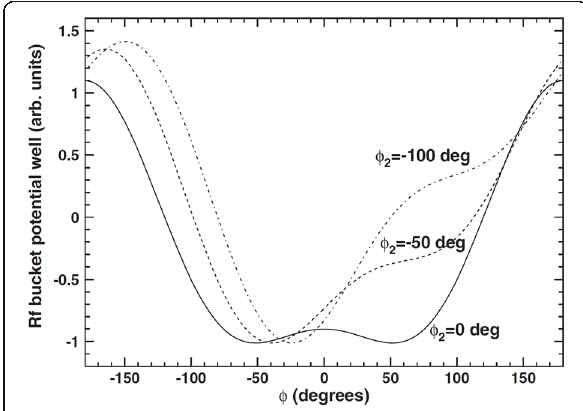
Fig. 16 Temporal variation of the RF bucket potential well; the phase offset of the second harmonic RF ( ϕ 2 ) is linearly swept from − 100 to 0° during injection